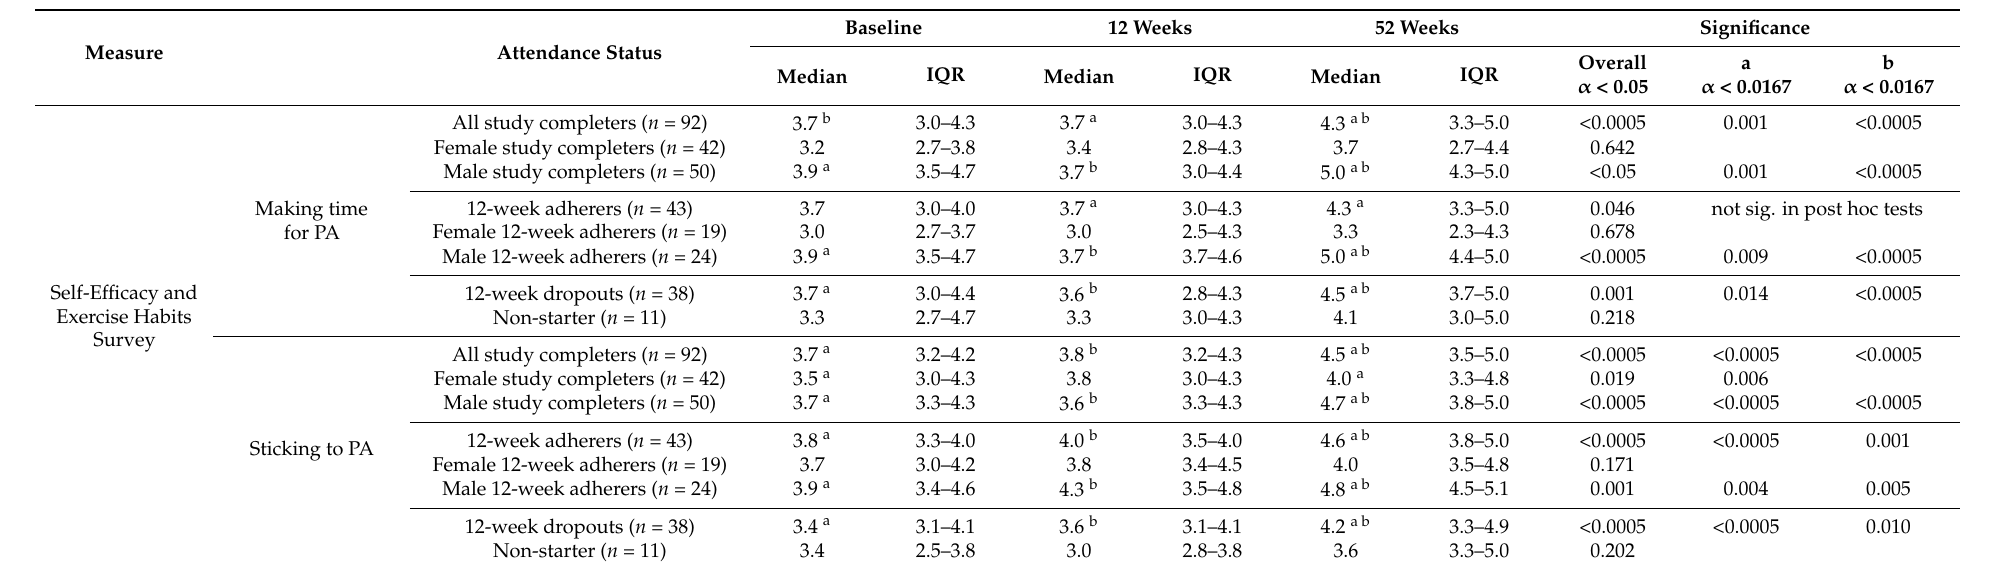
Table 7. Study completers: change in exercise